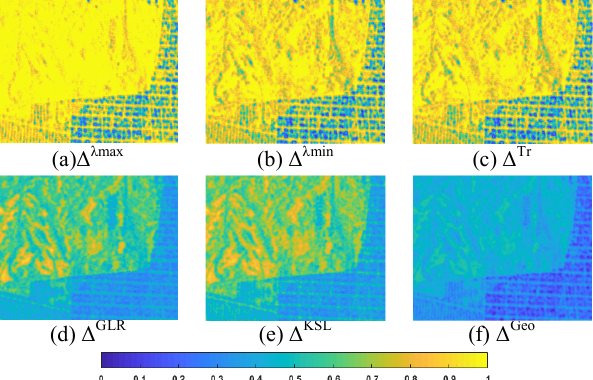
Figure 2. similarity of the image to the specified target A